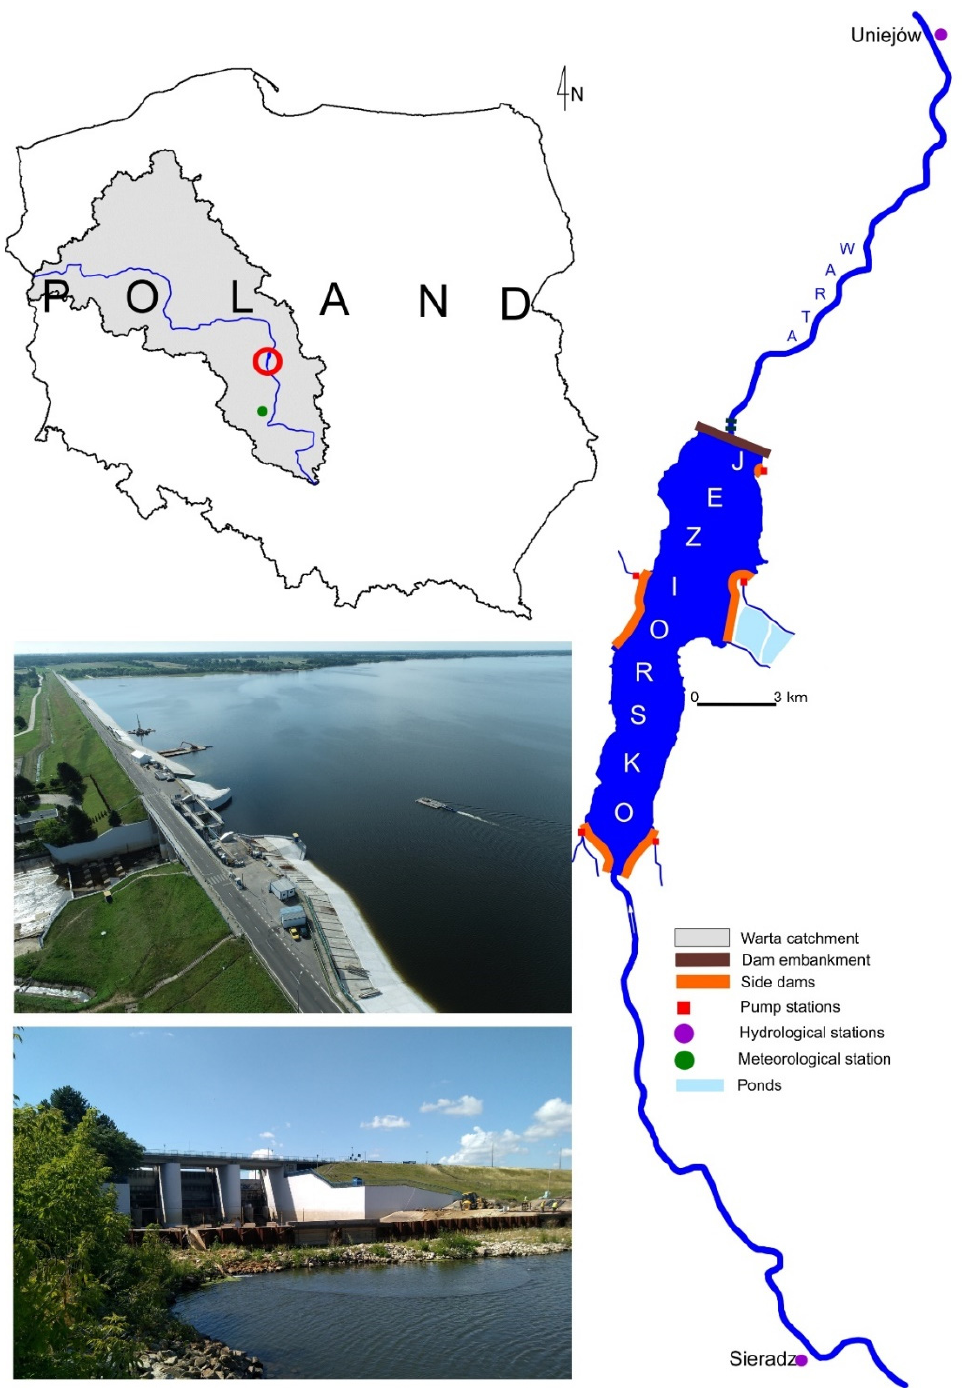
Figure 1. Location of the study object (photos: material of the Regional Water Management Board in Pozna ń and Wojciech Por ę ba)